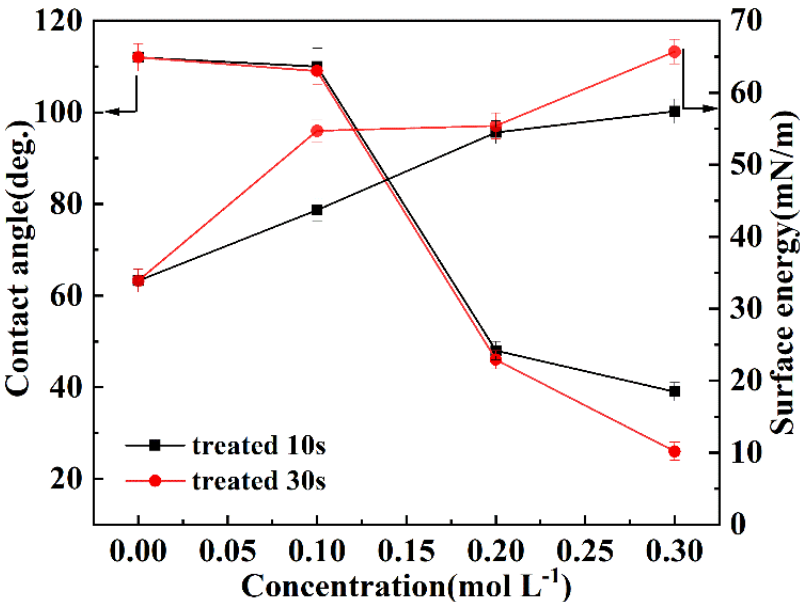
Figure 6. The variation trend of the contact angle and surface energy of FEP films with the concen- tration of sodium naphthalene-THF solution.